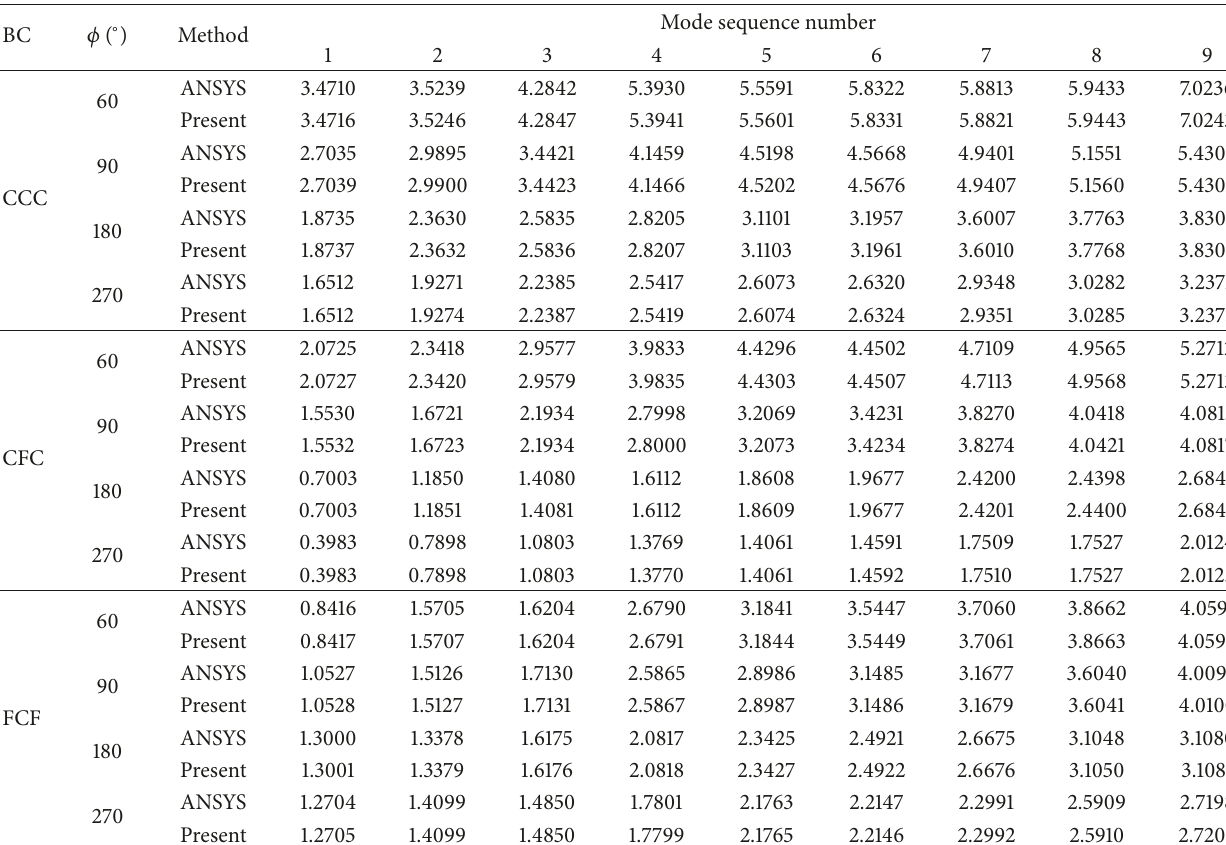
Table 4: Comparison of the first nine frequency parameters Ω = (2𝜔𝑅 1 /𝜋)√(𝜌/(𝐸(1 − ] 2 ))) for circular sector plate with various boundary